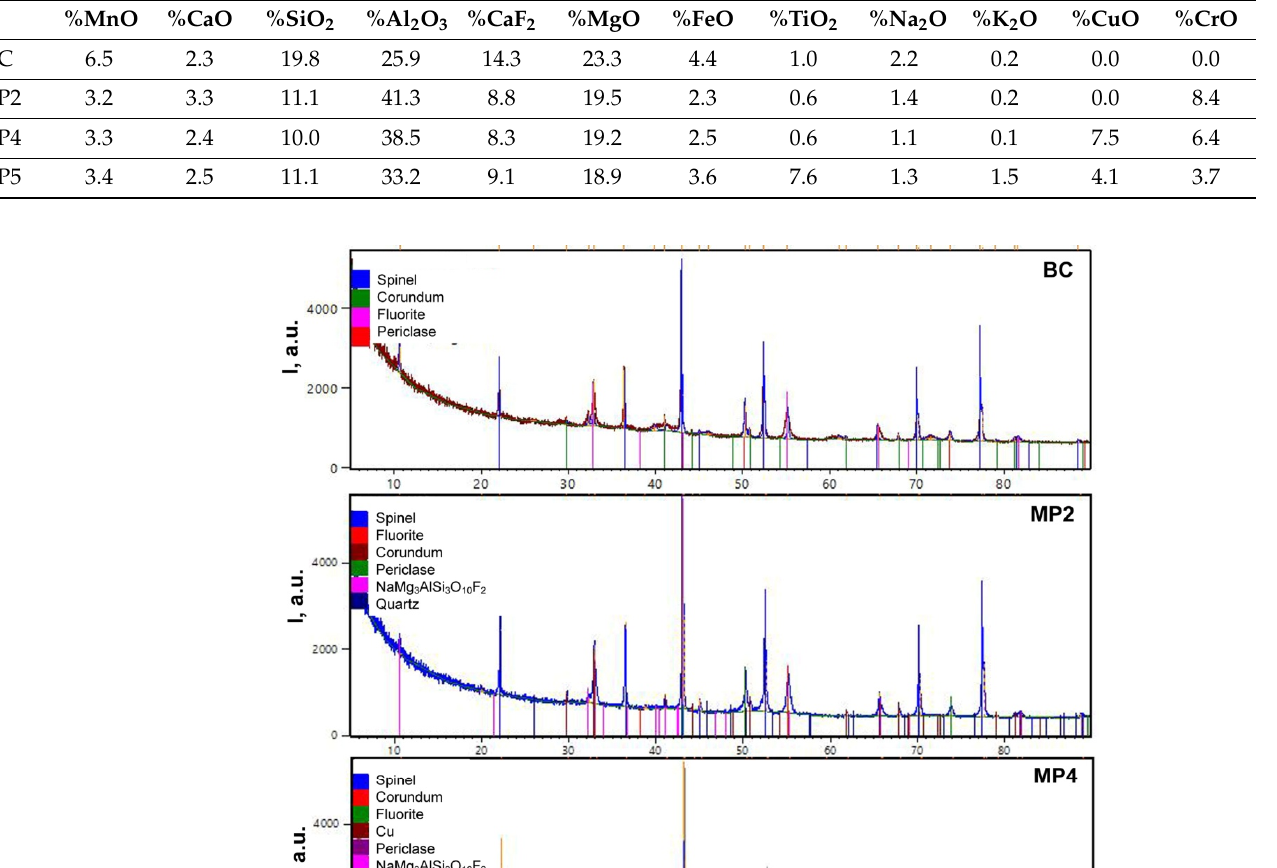
Table 3. Bulk chemical compositions of post-weld slags (mass%).